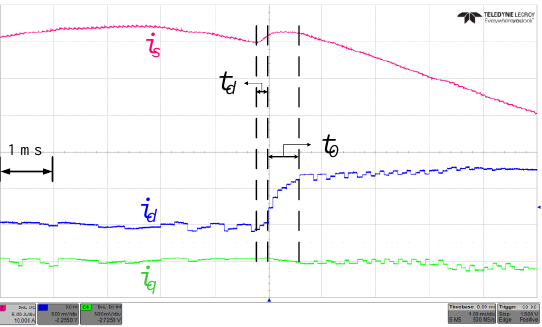
Figure 15. Details of the step responses with the proposed control strategy.